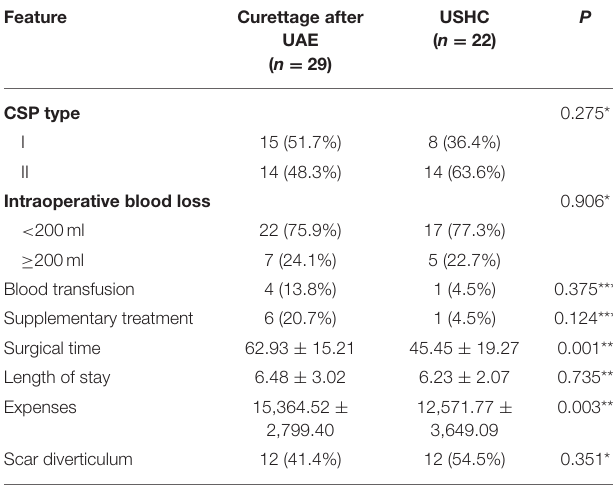
TABLE 3 | Comparison between surgical